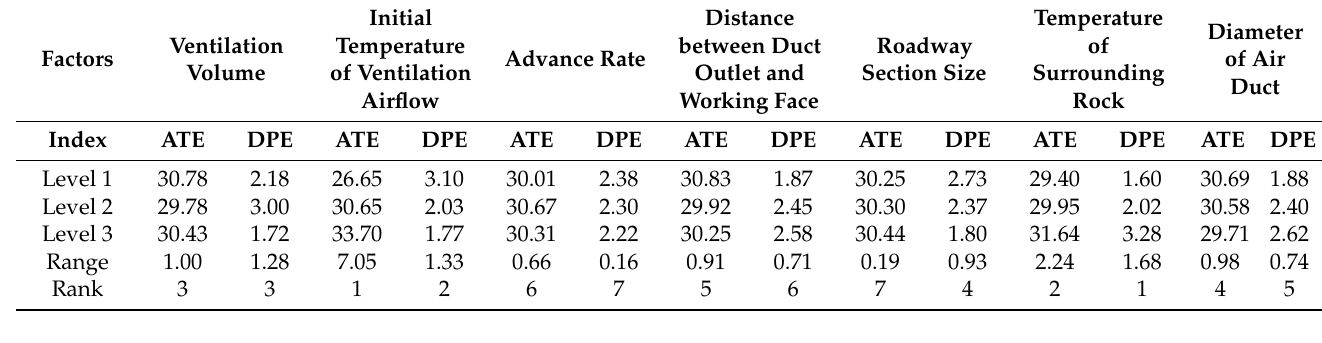
Table 3. Orthogonal test Range calculation of air temperature.